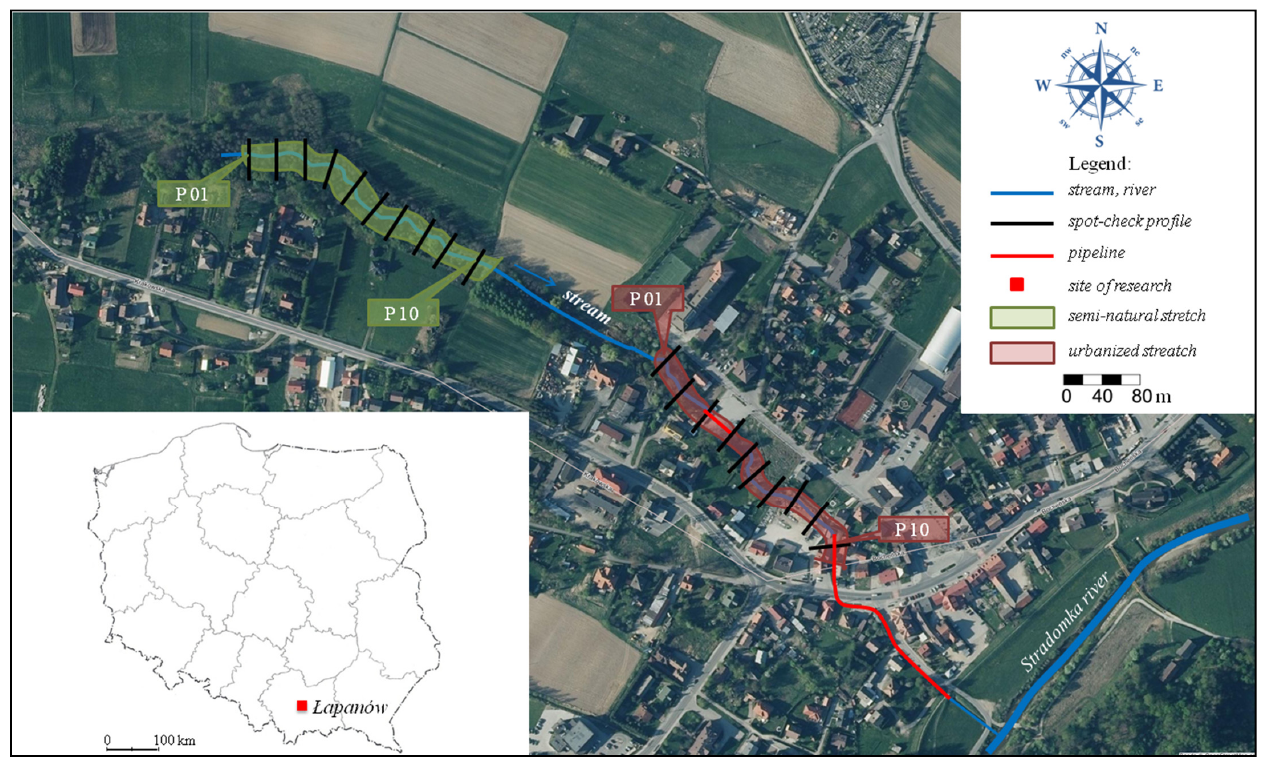
Figure 1. Location of the studies and sections with control profiles on the stream.